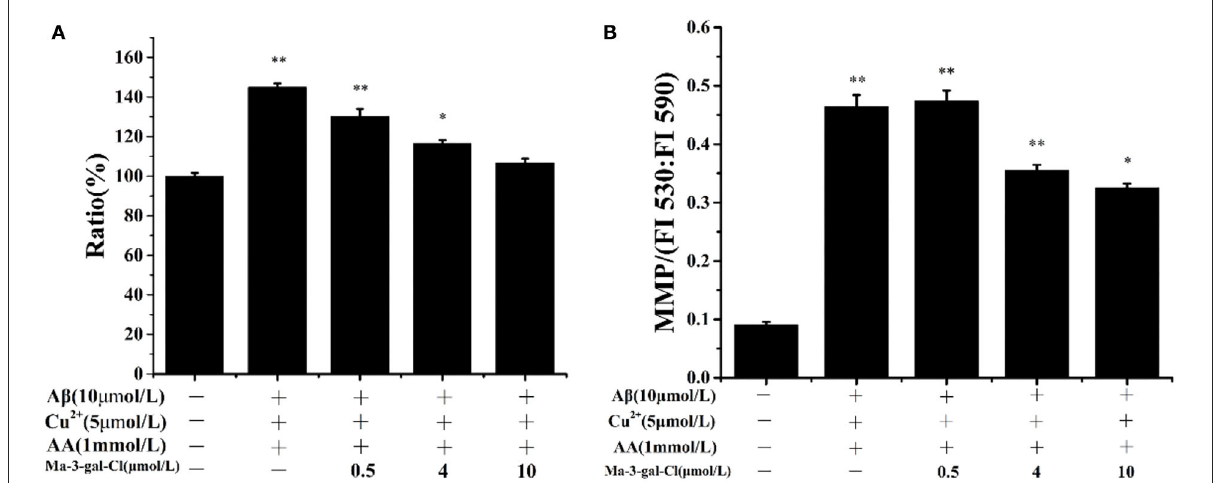
FIGURE4 Intracellular ROS ratio (A) and MMP (B) of SH-SY5Y cells which were treated with A β (1–42)/Cu 2 + /AA mixture in the absence or presence of different concentrations of Ma-3-gal-Cl. * P < 0.05 and ** p < 0.01 compared to control